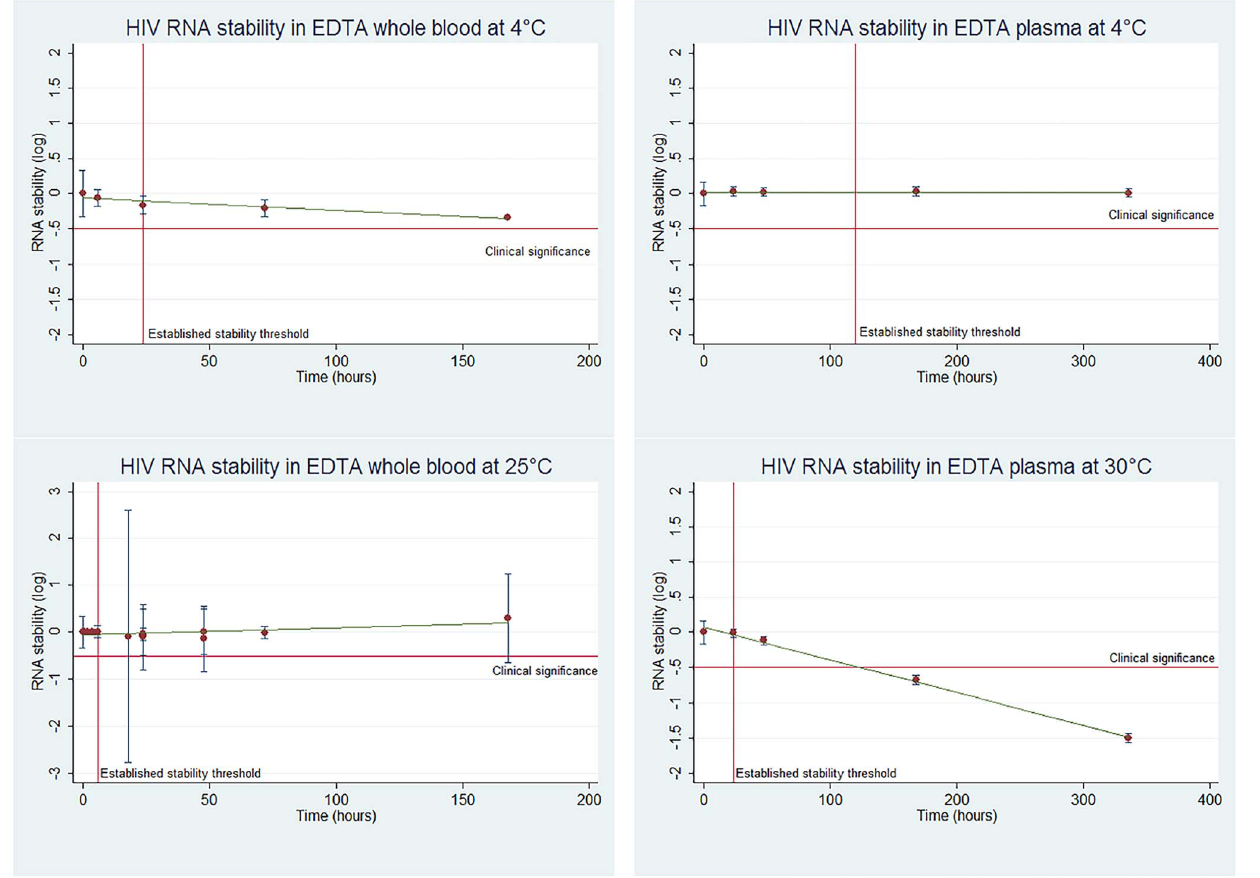
Figure 2. RNA degradation in EDTA tubes over time and